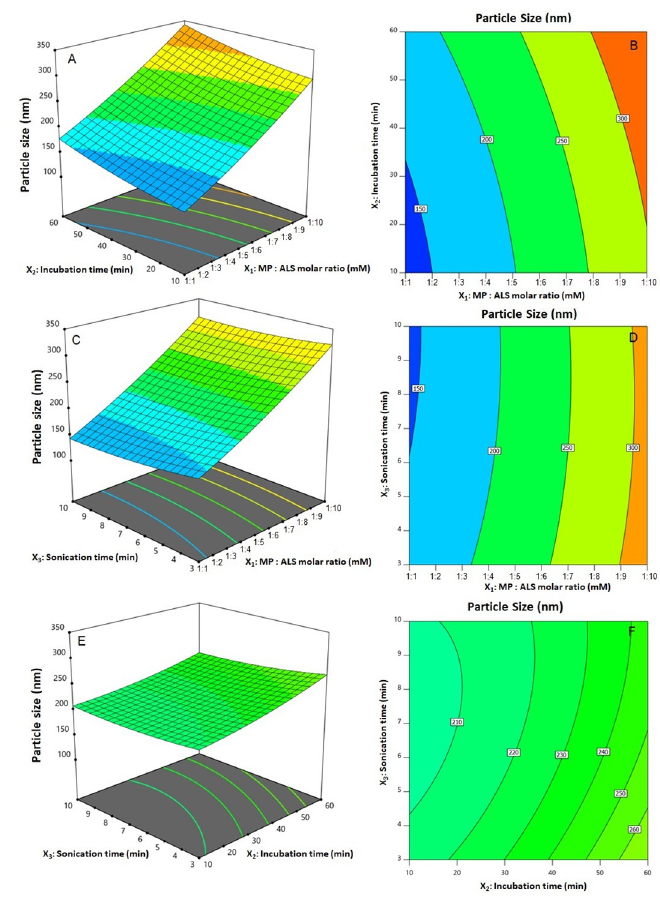
Fig 2. Response 3D-plots (A-C) and contour 2D-plots (D-F) for the influence of ALS:MP molar ratio (X1), incubation time (X2), and sonication (X3) on the particle size of ALS-MP